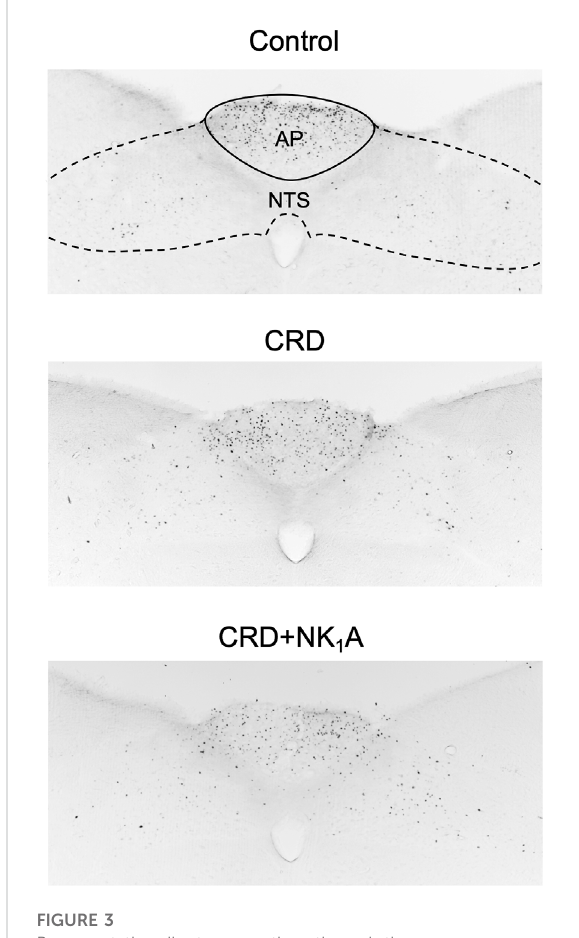
FIGURE 3 Representative vibratome sections through the area postrema (AP) and the nucleus of the solitary tract (NTS) from the groupsstimulatedbycolorectaldistension(GroupCRDandCRD+ NK 1 A) and non-stimulated (Control) rats. Group CRD received saline, and Group CRD + NK 1 A received fosaprepitant (30 mg/kg)intraperitoneallybeforethestimulation.Thenumberof c-Fos immunoreactive cells in the NTS in the stimulated groups (CRD and CRD + NK 1 A) was higher than in the Control